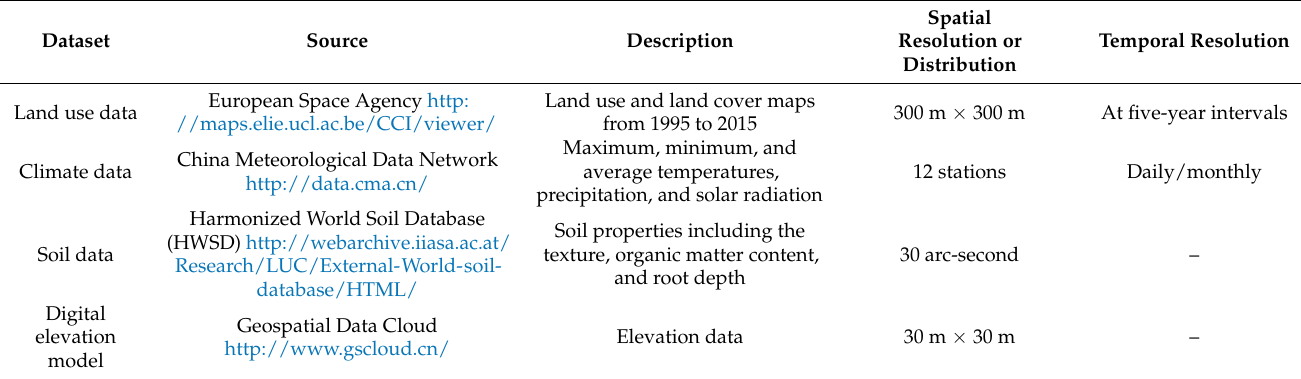
Table 1. Description of the datasets adopted in this study.